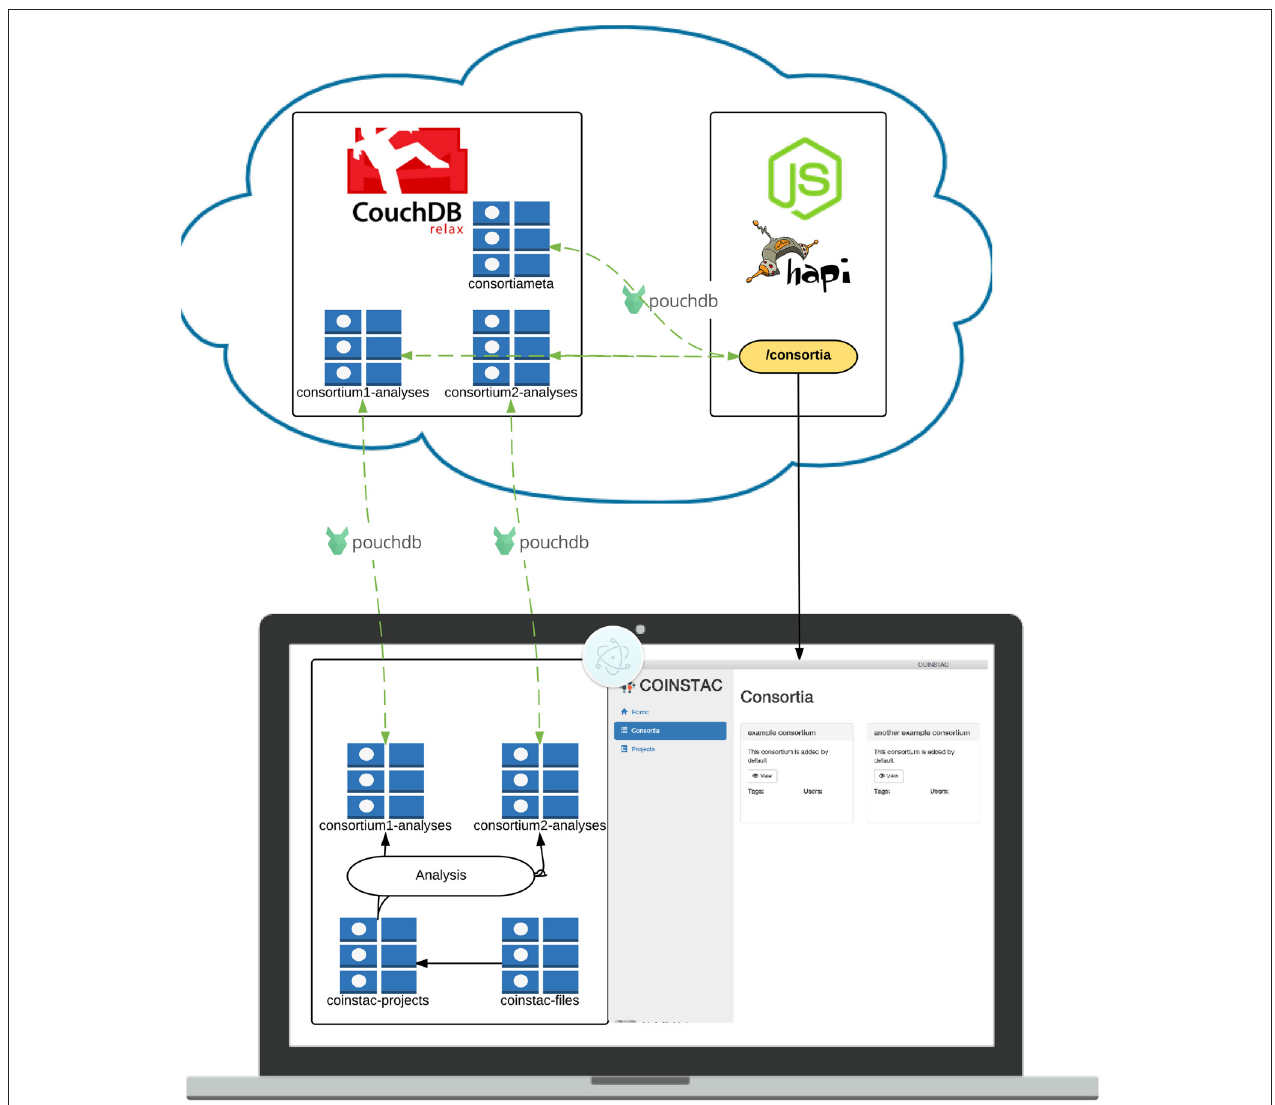
FIGURE 4 | Architecture of the COINSTAC implementation. The client is a desktop application written using standard web technologies on top of the Electron (2015) and Node.js (2015). Electron enables installation on any major OS and access to low level system utilities not available to browser-based web apps. The server is a RESTful API running on top of Node.js (2015) and Hapi.js (2015). Data is stored in multiple CouchDB (2015) datastores. Client-server data transfer takes place via the RESTful webservice, and synchronization mechanisms that are built into CouchDB